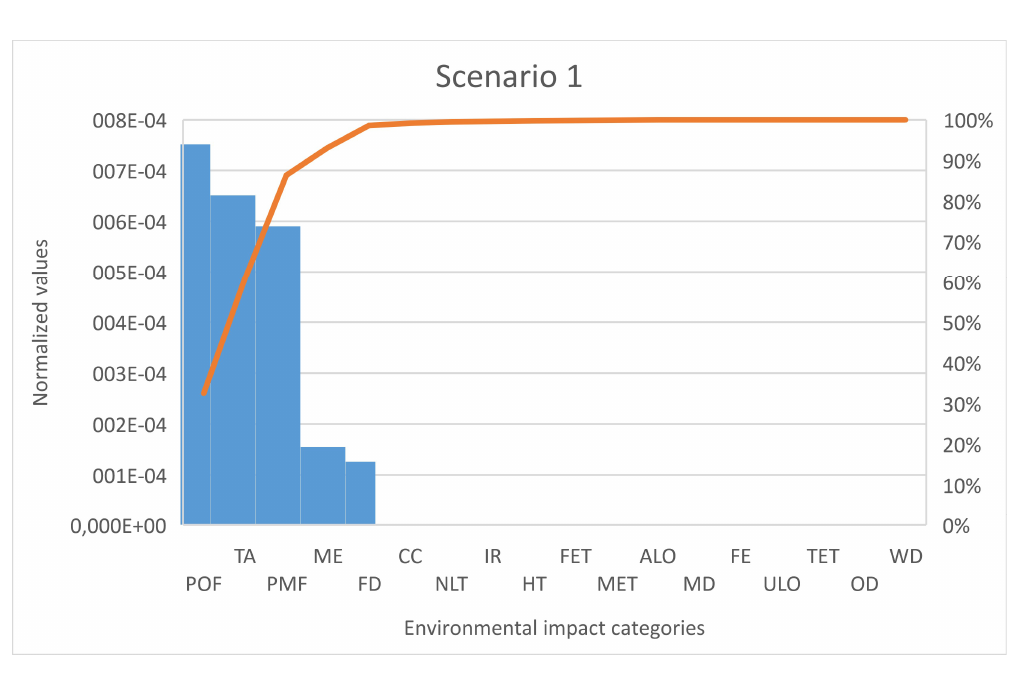
Figure 4. Pareto analysis for scenario 2 (only visible values). In the next step, it is important to define the hotspots in the processes (most impactful processes) for both scenarios. Therefore, further analysis of the potential contribution of the processes for the most critical impact categories was performed. In this analysis, the categories cannot be compared between each other. The analysis is based on the characterization values, and therefore, it is focused on one impact category at the time, influenced in different ratios (%) by different processes. The results for the processes contribution are summarized in Table 9. In the category of climate change, the flow of captured CO 2 is referred to as environmental credit. However, in both cases, the CO 2 emissions and clean flue gases are still released to the air and therefore contribute to the environmental impacts. Some of the processes do not have any relative impact to the environmental categories.